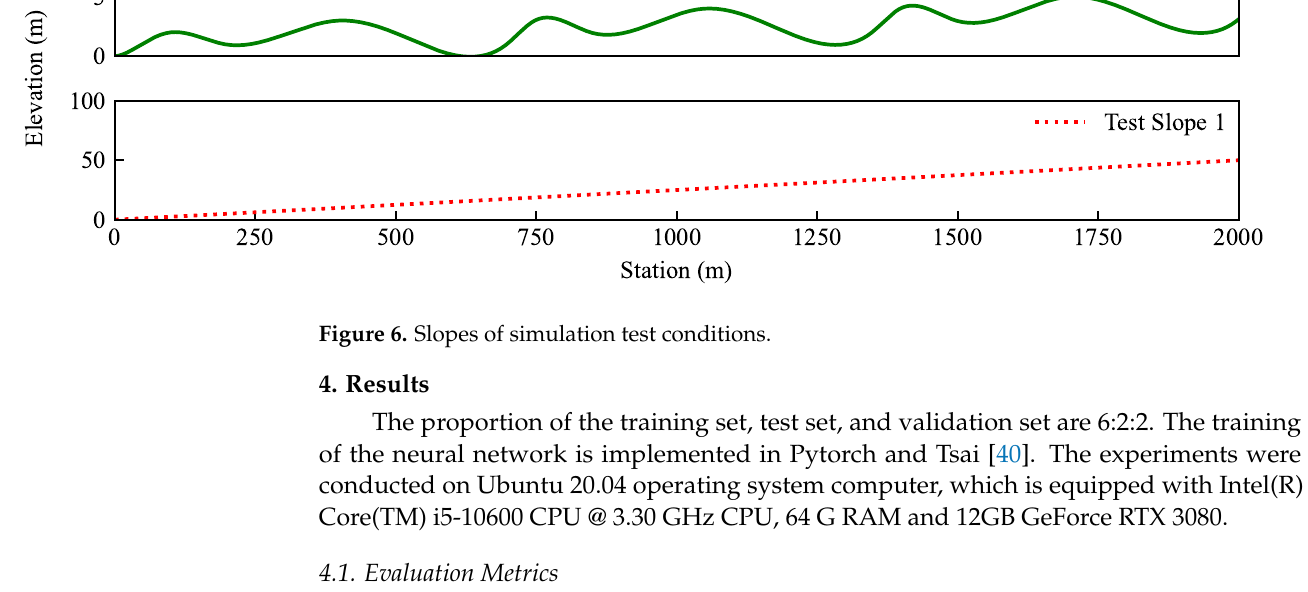
( Slopes profiles. a ) : : :::::: :::::::